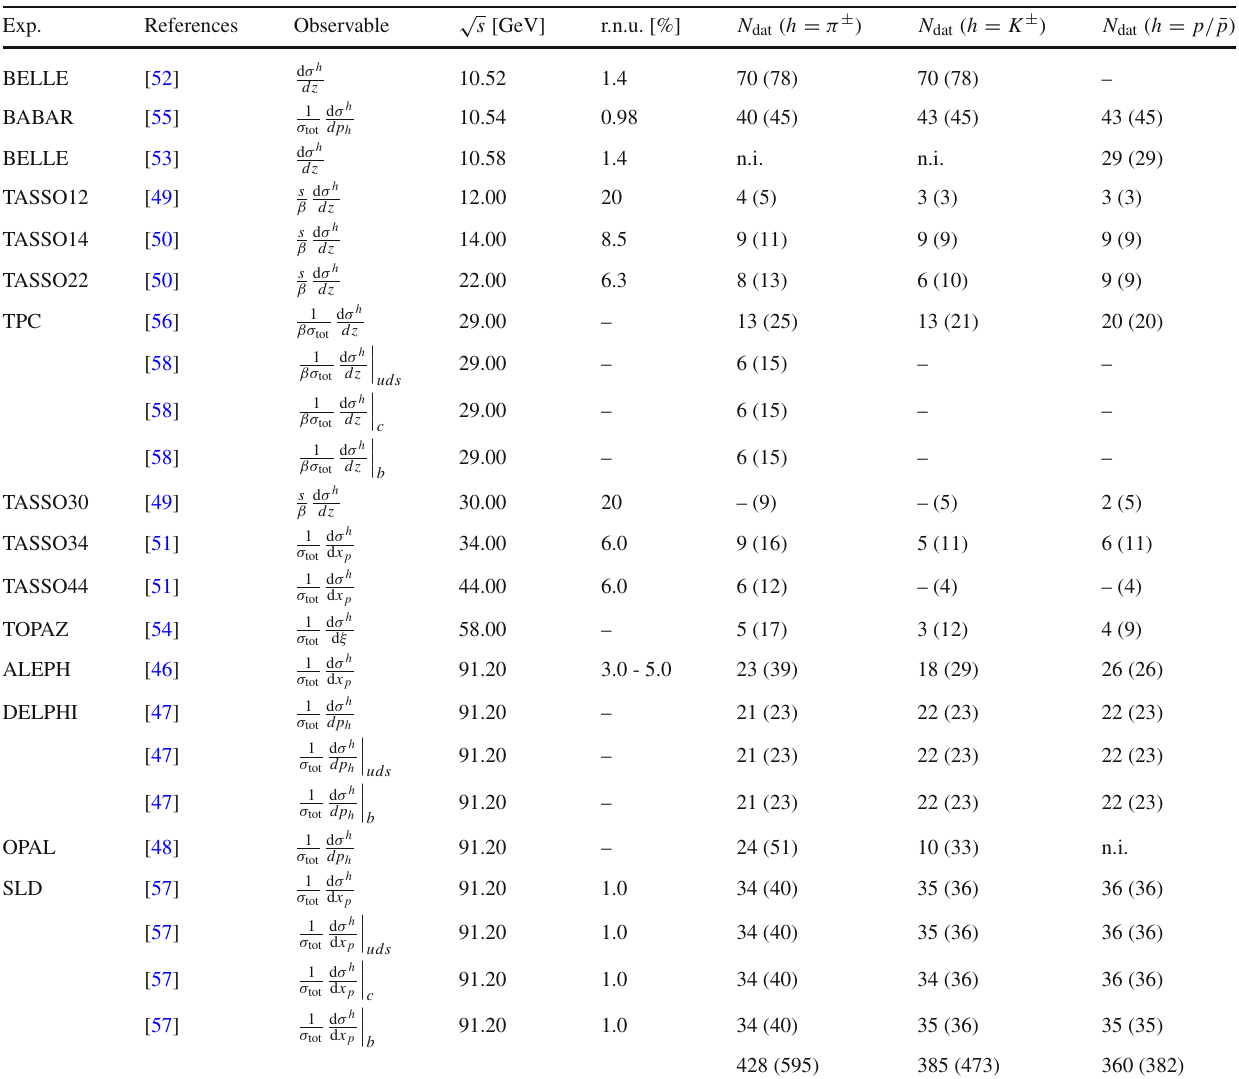
Table 1 The dataset included in the NNFF1.0 analysis for charged pions, π ± = π + + π − , charged kaons, K ± = K + + K − , and pro- tons/antiprotons, p / ¯ p = p + ¯ p . For each experiment, we indicate the publication reference, the measured observable, the center-of-mass